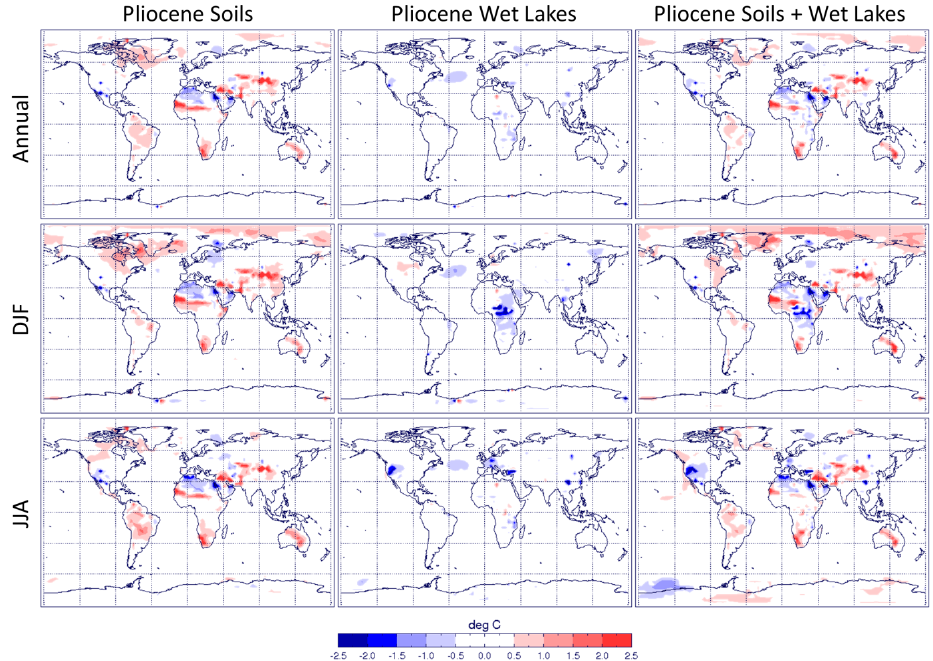
Fig. 4. Mean annual and seasonal surface air temperature for the soil and lake experiments. Anomalies relative to the standard PRISM3 Figure 4. Mean annual and seasonal surface air temperature for the soils and lakes 840 control run (with modern lake and soil distribution). Everything plotted is significant at the 0.1% confidence experiments. Anomalies relative to the standard PRISM3 control run (with modern lake and 841 soil distribution). Everything plotted is significant at the 0.1% confidence level. 842